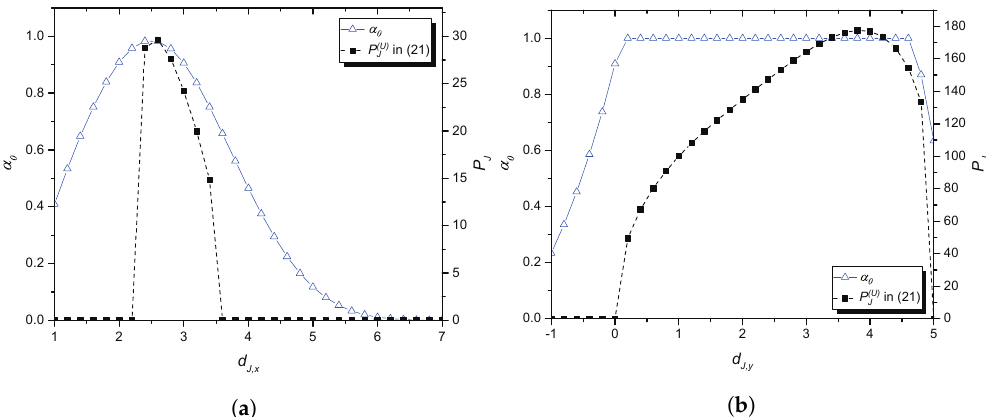
Figure 4. Power allocation for the collaboration: ( a ) the jammer moves horizontally; ( b ) the jammer moves vertically.